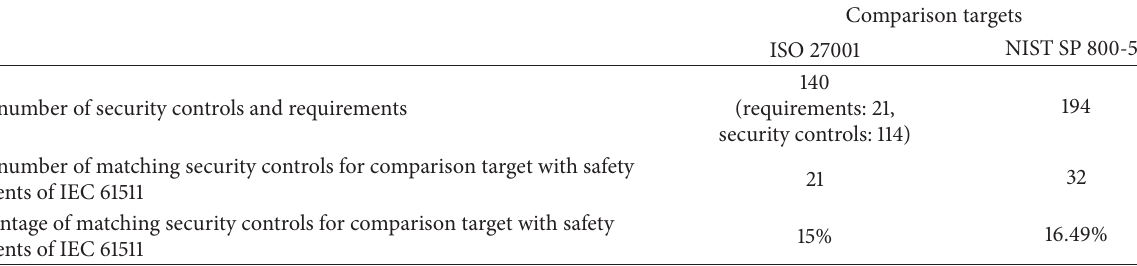
Table 2: The matching analysis for requirements or security controls of international standards.